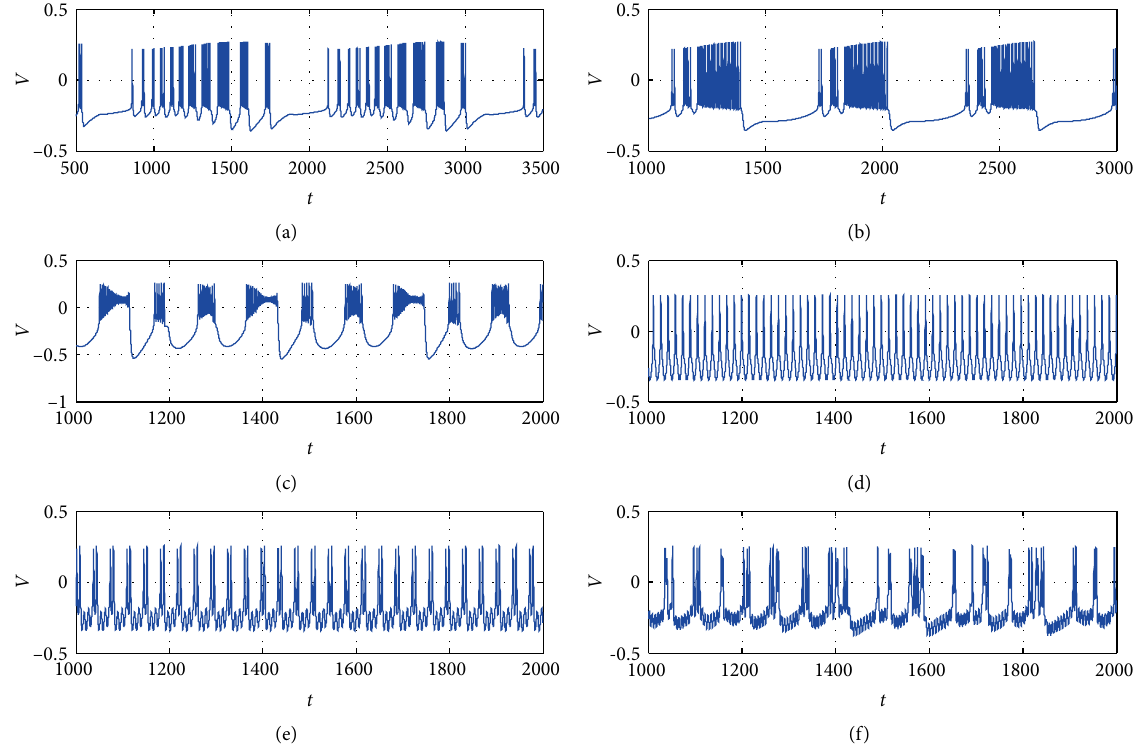
Figure 2: Sampled time series for membrane potential when the angular frequency of external forcing currents is chosen as different values with fixed intensity 𝐼 = 0.05 . (a) 𝜔 = 0.005 , (b) 𝜔 = 0.01 , (c) 𝜔 = 0.06 , (d) 𝜔 = 0.4 , (e) 𝜔 = 0.7 , and (f) 𝜔 = 1.0 . The effect of electromagnetic radiation is considered by setting 𝑘 , 𝑘 , and 𝑘 . 1 = 0.2 2 = 0.15 3 = 0.15